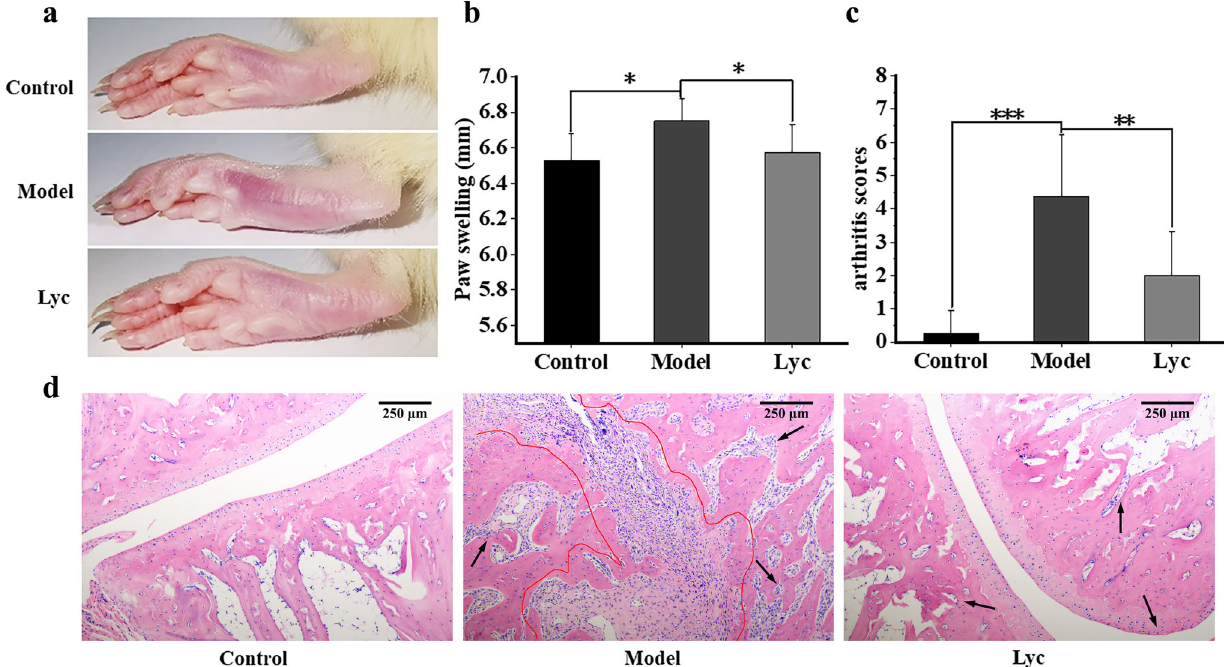
Fig. 1 The severity of rheumatoid arthritis. a Joint swell of the left hind foot. b The diameter of paw swell in each group (mm). c The arthritis score of rats in each group. The error bars on the bar charts represented the standard deviations. The “ * ” indicated the P value was less than 0.05, “ ** ” indicated the P value was less than 0.01, and “ *** ” indicated the P value was less than 0.001. d Pathological sections of joint after HE staining in each group. Black arrow: diffusion or in fi ltration of in fl ammatory cells. Red circle: synovial hyperplasia and hypertrophy and formation of pannus. The magni fi cation was 100×. The length of the scale bar was 250 μ